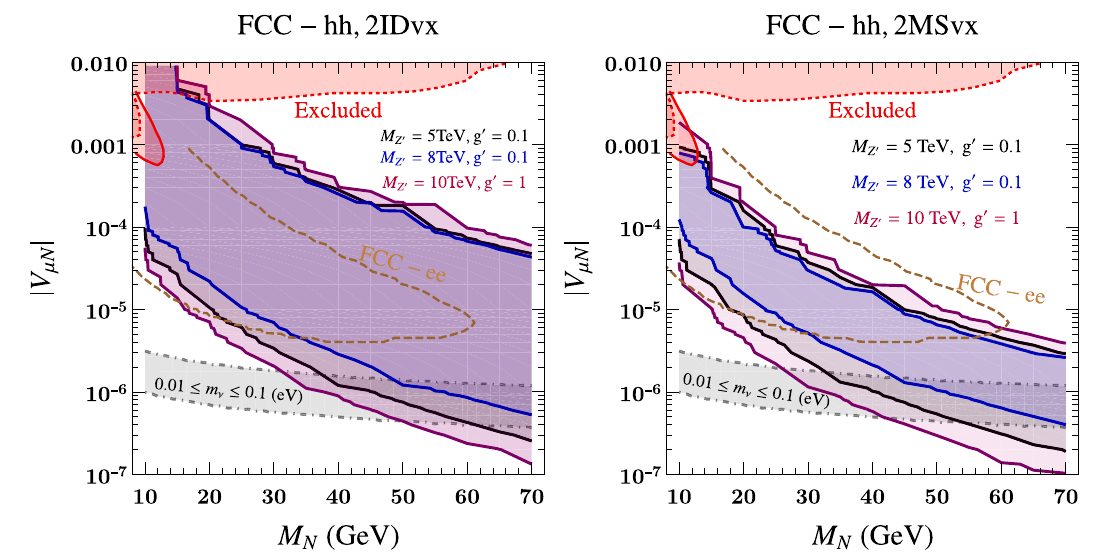
Fig. 17 95% CL sensitivity of the FCC-hh with L = 30 ab − 1 towards the active-sterile neutrino mixing strength | V μ N | , as a function of the RHNmass M N andfordifferentchoicesof M Z (cid:2) and g (cid:2) (solidcontoursas indicated).Theleftandrightpanelsshowthesensitivityusingthe2IDvx and 2MSvx signature, respectively. The brown dashed line represents